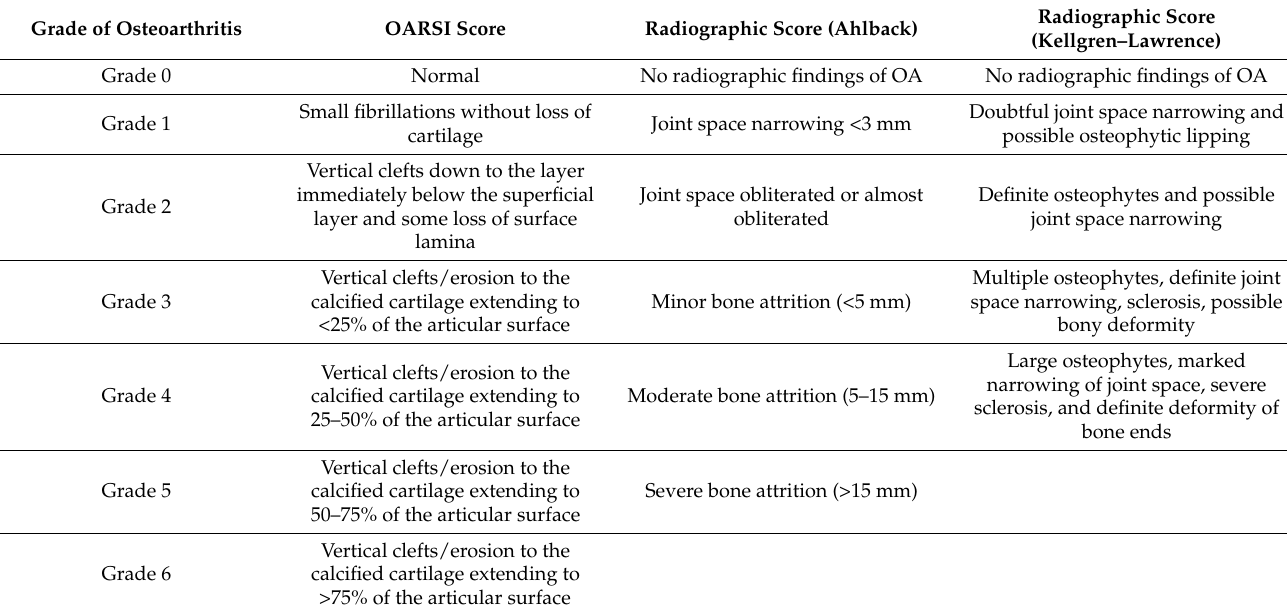
Table 1. Different evaluation score for osteoarthritis.